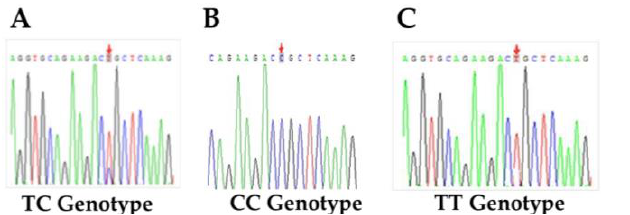
Figure 3. Sanger sequencing of SNP rs81471943 (C/T) on EXOC4. SNP rs81471943 (C/T) polymor- phism locus is located at position 16,079,412 of chromosome 18, and the three genotypes were CC ( A ), CT ( B ), and TT ( C ), respectively. M1000: DNA marker of 1000 bp.